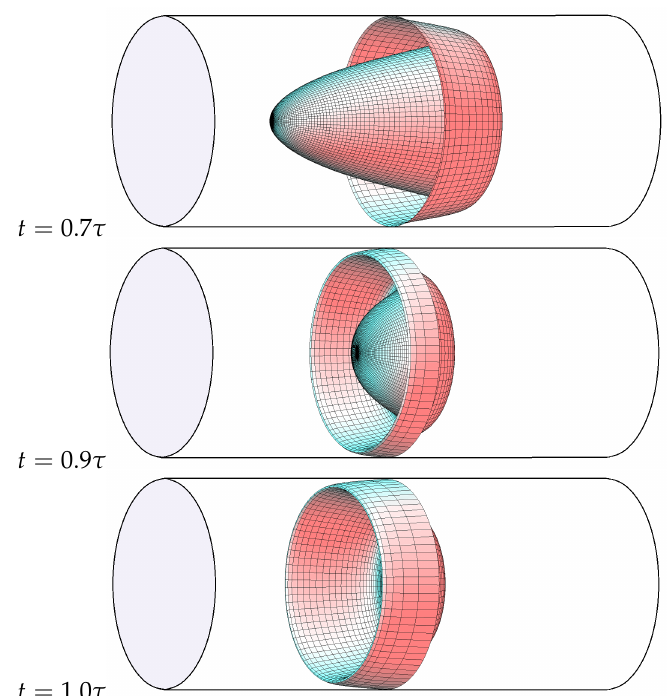
Figure 4. Time evolution of non-stationary thermovibrational fluid flow induced by the internal heat generation in a closed pipe at different moments in time over a half-period of vibrations τ . Gr V Pr = 1000. Ω = 100. The half-period of vibrations is equal to τ = π